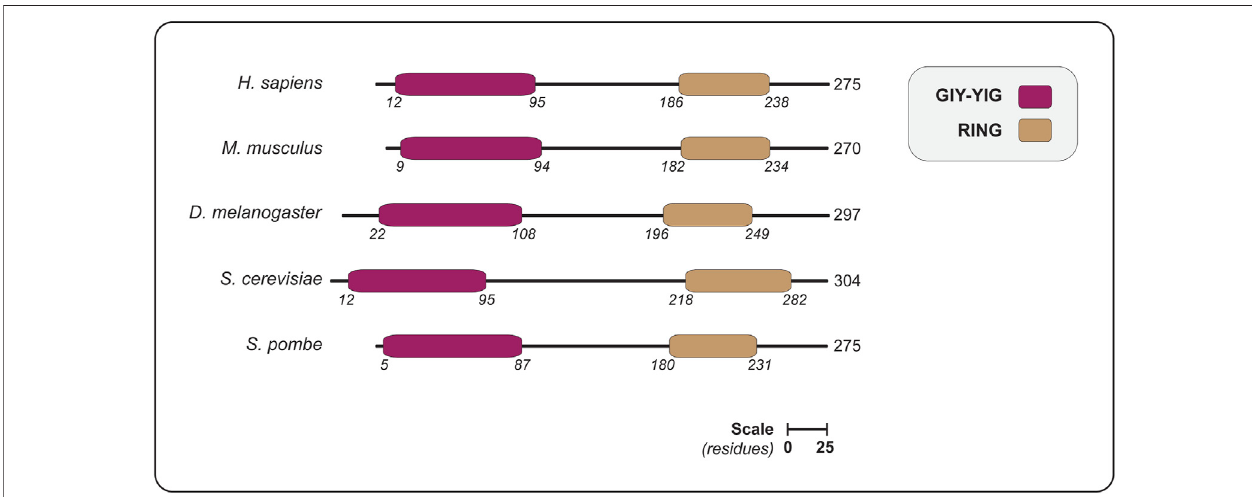
FIGURE 2 | The domain organization of SLX1 proteins from different eukaryotes, showing the positions of the GIY-YIG nuclease domain and RING domain. Domains are colored as indicated in the legend (upper right). The length of each protein is indicated in amino acids, as are the domain boundaries. All the proteins are shown on the same scale (scale bar represents 25 residues). Abbreviations for protein domains: GIY-YIG, amino acids that form the catalytic motif; RING, really interestingnew gene.Abbreviationsfor organism namesand UniProtidenti fi er(in parenthesis): H. sapiens , Homosapiens (Q9BQ83); M.musculus , Musmusculus (Q8BX32); D. melanogaster , Drosophila melanogaster (Q9VN41); S. cerevisiae , Saccharomyces cerevisiae (P38324); S. pombe , Schizosaccharomyces pombe